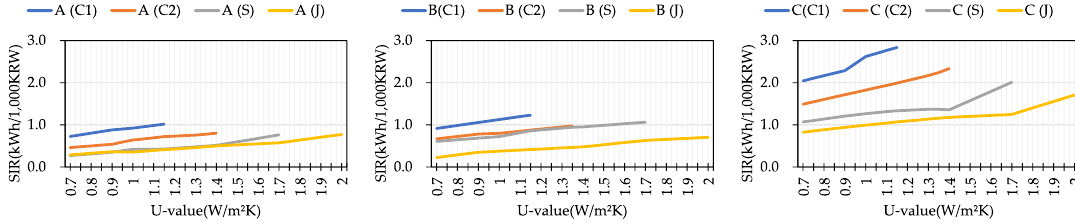
Figure 7. The SIR for A to C according to climate condition with the U-value of window in 4